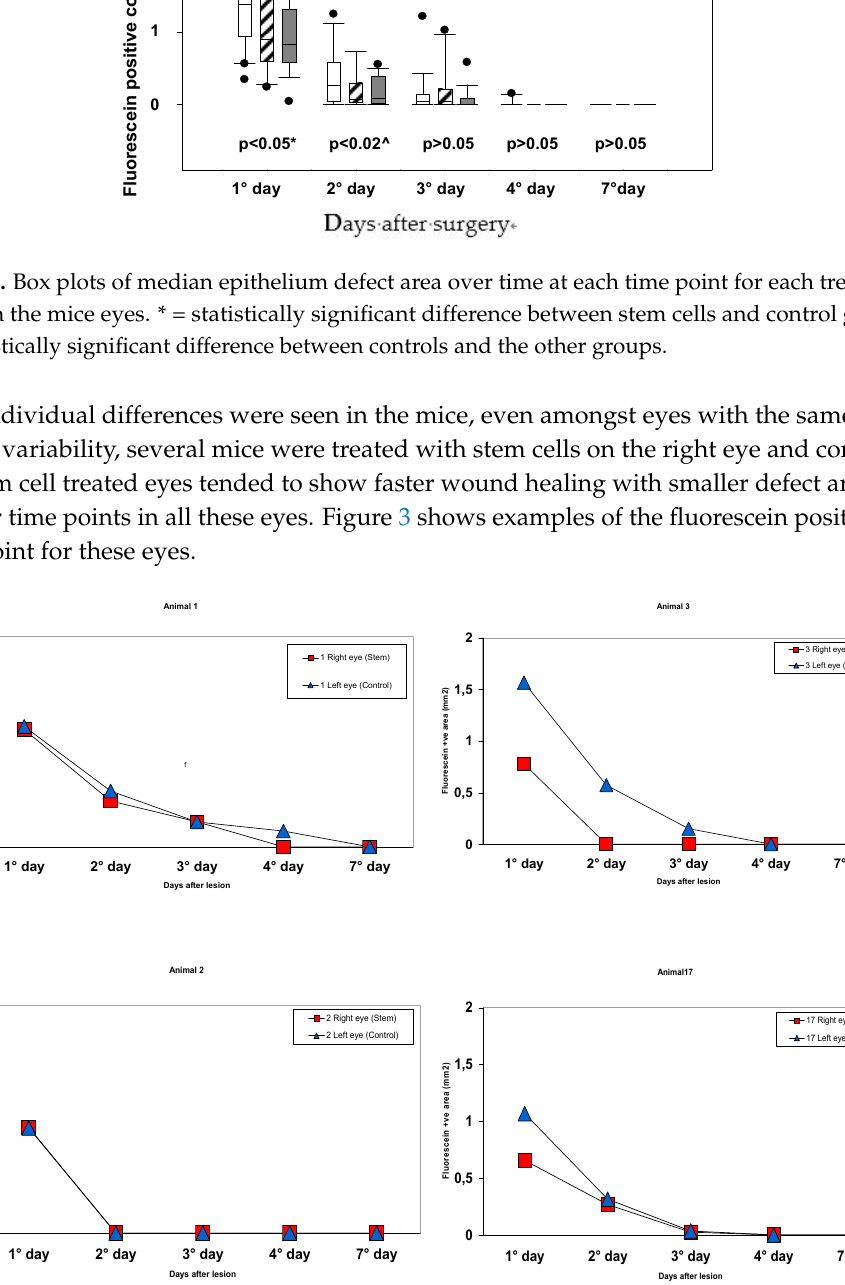
Figure 3. Fluorescein positive areas at each time for animals # 1, 2, 3, and 17. For intraindividual comparisons, the right eye (red squares) of each mouse was treated with stem cells and the left eye (blue triangles) was treated with the control regimen. The stem cell eyes tended to show better epithelial wound healing than the control eyes in the first three days with smaller fluorescein areas and faster total re-epithelization.